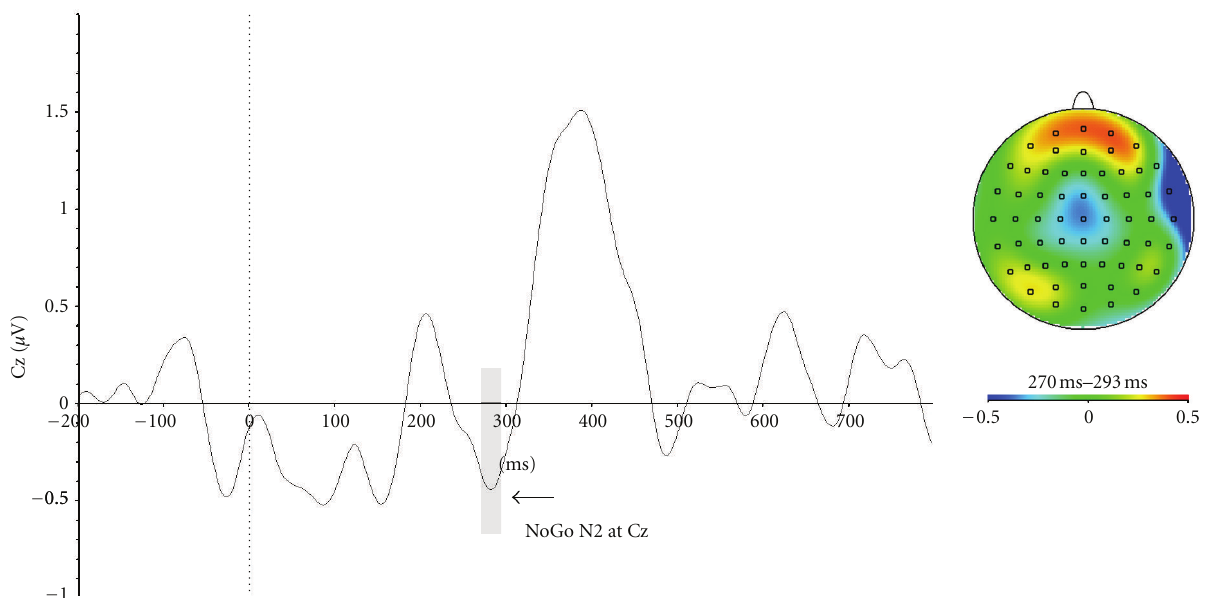
Figure 3: Event-related potentials that isolate no-go N2 component. We subtracted the average waveform from the frequent-target, frequent colour, condition (the most frequently-occurring condition) from the same-colour (no-go) condition; this figure shows this di ff erence wave at Cz.